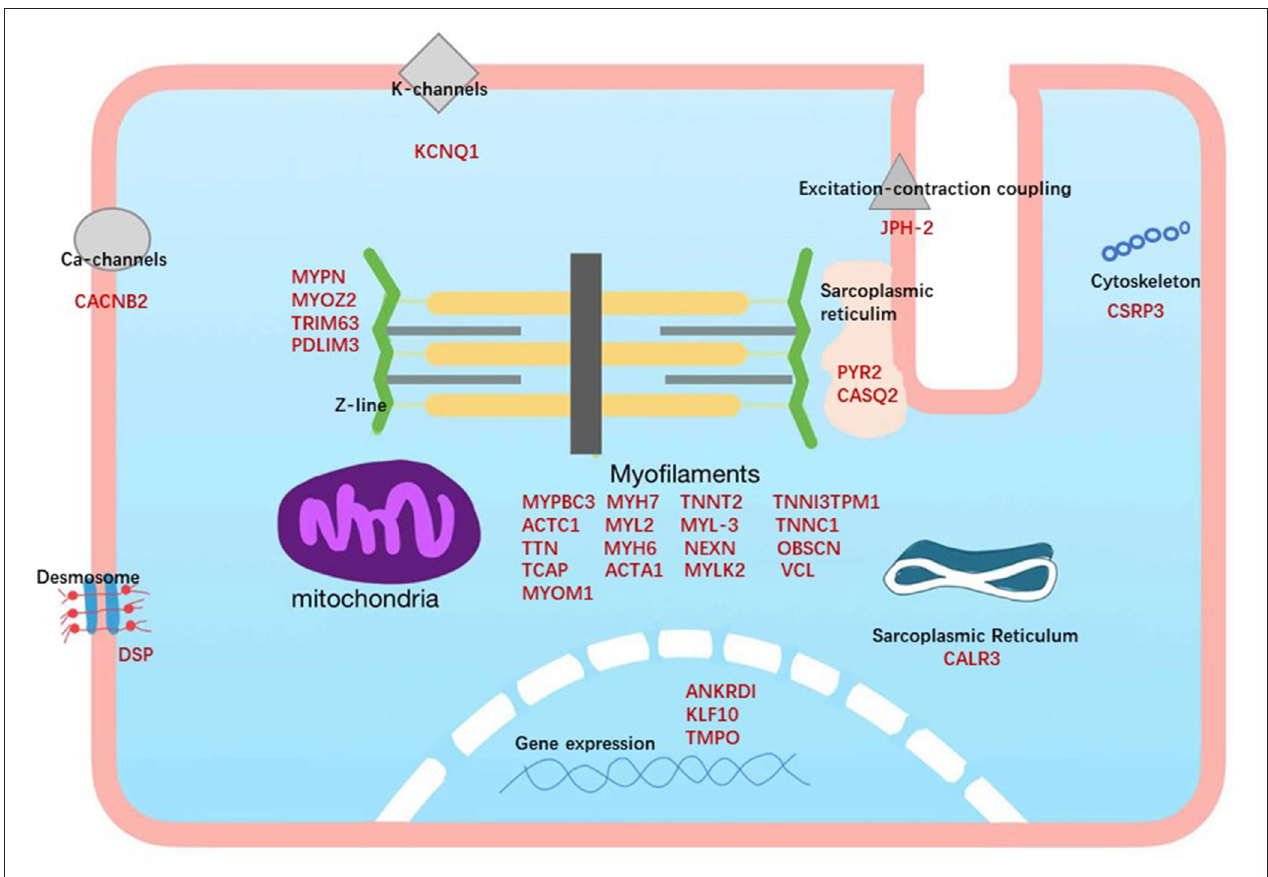
FIGURE 2 | Subcellular locations of the proteins encoded by the genes associated with hypertrophic cardiomyopathy. HCM genes are shown in